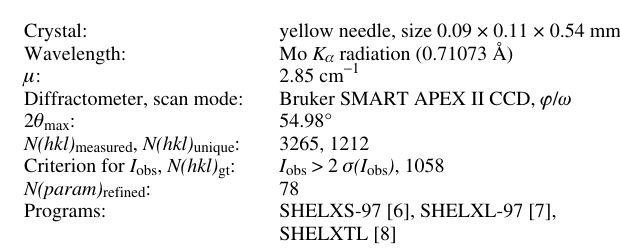
Table 1. Data collection and